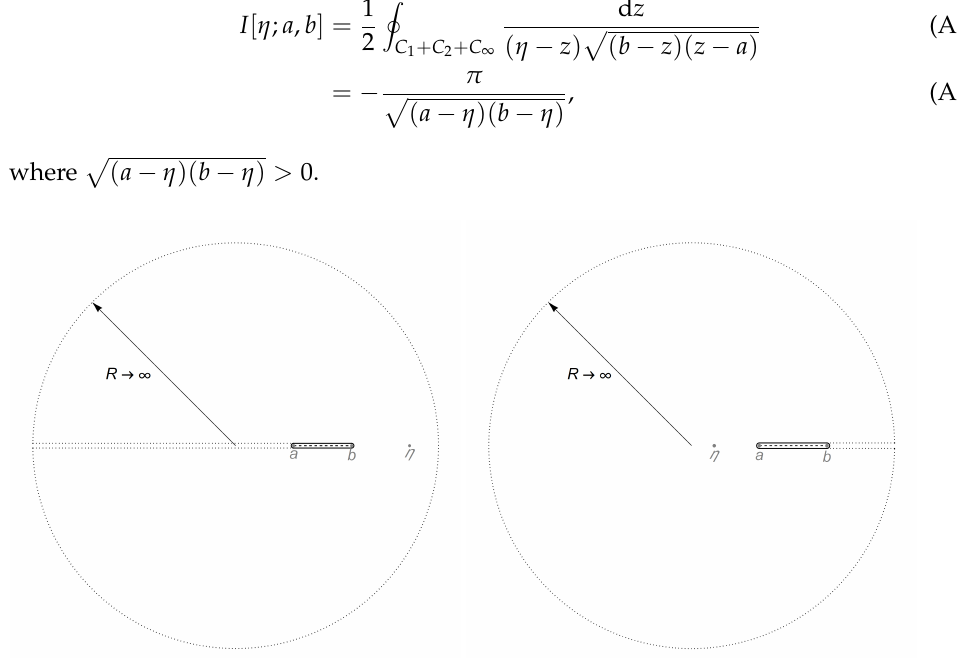
Figure A1. Cosmic string integral: Both panels represent the complex z plane. The a , b , and η lie on the Real line. We choose the branch cut to be the black dashed line joining a and b . The C 1 + C 2 contour in the main text refers to the clockwise closed loop in black encircling a and b . Left Panel: When η > b > a , we may extend the a -end of this closed loop off to − ∞ on the Real line, and then make a radius R → ∞ counterclockwise circle back to itself. This converts the small black clockwise closed loop into the large counterclockwise dotted closed loop, whose associated integral can be evaluated via the residue at z = η . Right Panel: On the other hand, when η < a < b , we may extend the b -end of the black closed loop off to + ∞ on the Real line, and then make a radius R → ∞ counterclockwise circle back to itself. The integral around the small black clockwise closed loop is therefore equal to that around large counterclockwise dotted closed loop, which in turn can be evaluated through the residue at z = η